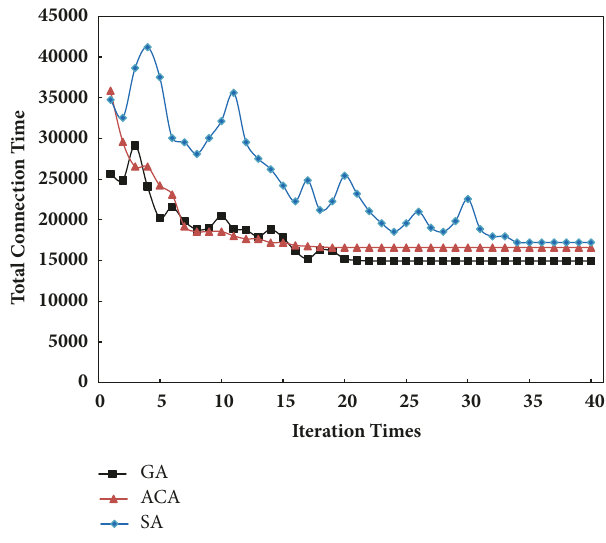
Figure 8: Comparison of convergence